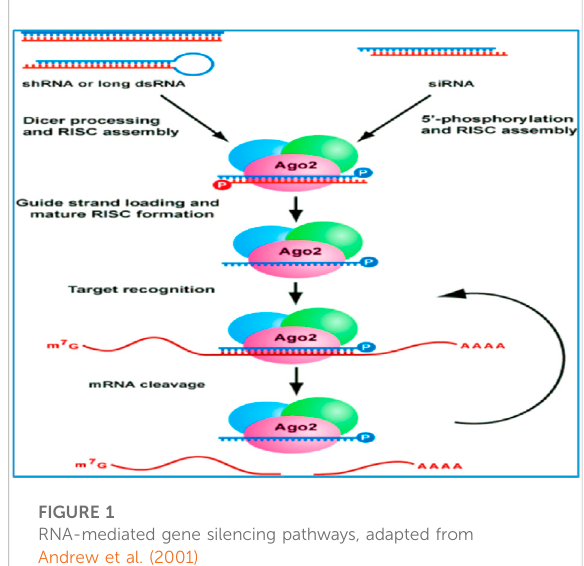
FIGURE 1 RNA-mediated gene silencing pathways, adapted from Andrew et al.